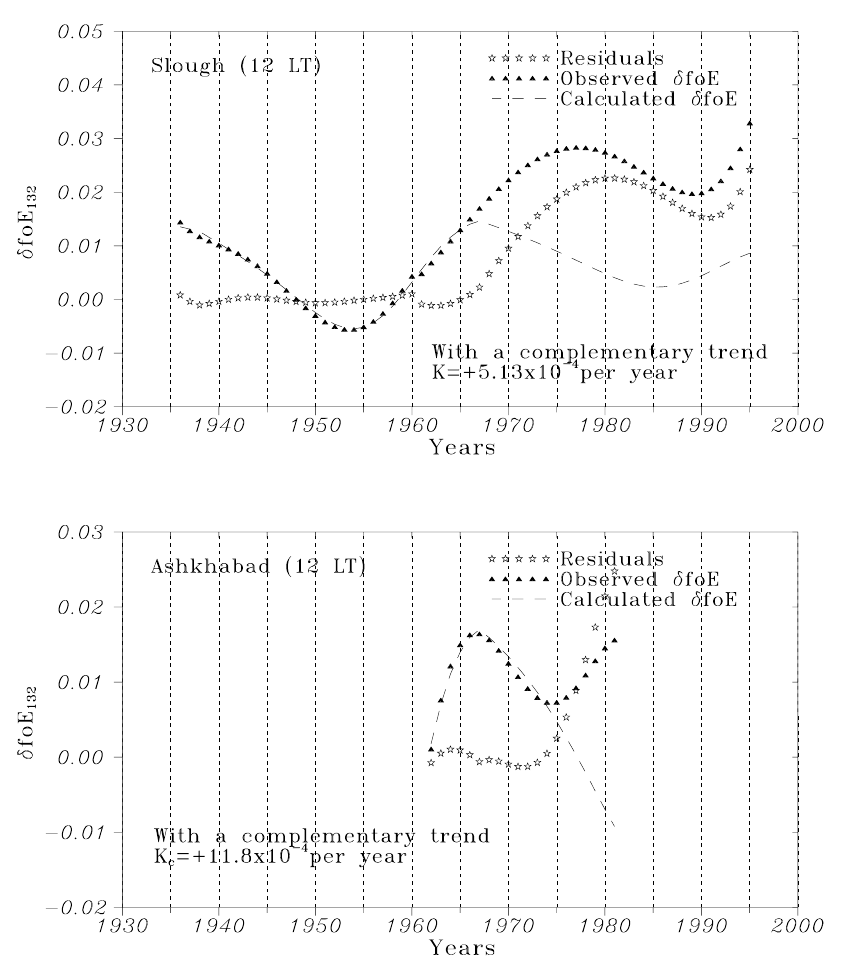
Fig. 4. Polynomial approximated ob- served, calculated δ fo E 132 and their dif- ference, resulting in practically zero residual fo E trends on Slough and Ashkhabad for the period before the “break down” effect occurs. Calcula- tions were performed with the comple- mentary trends given on the